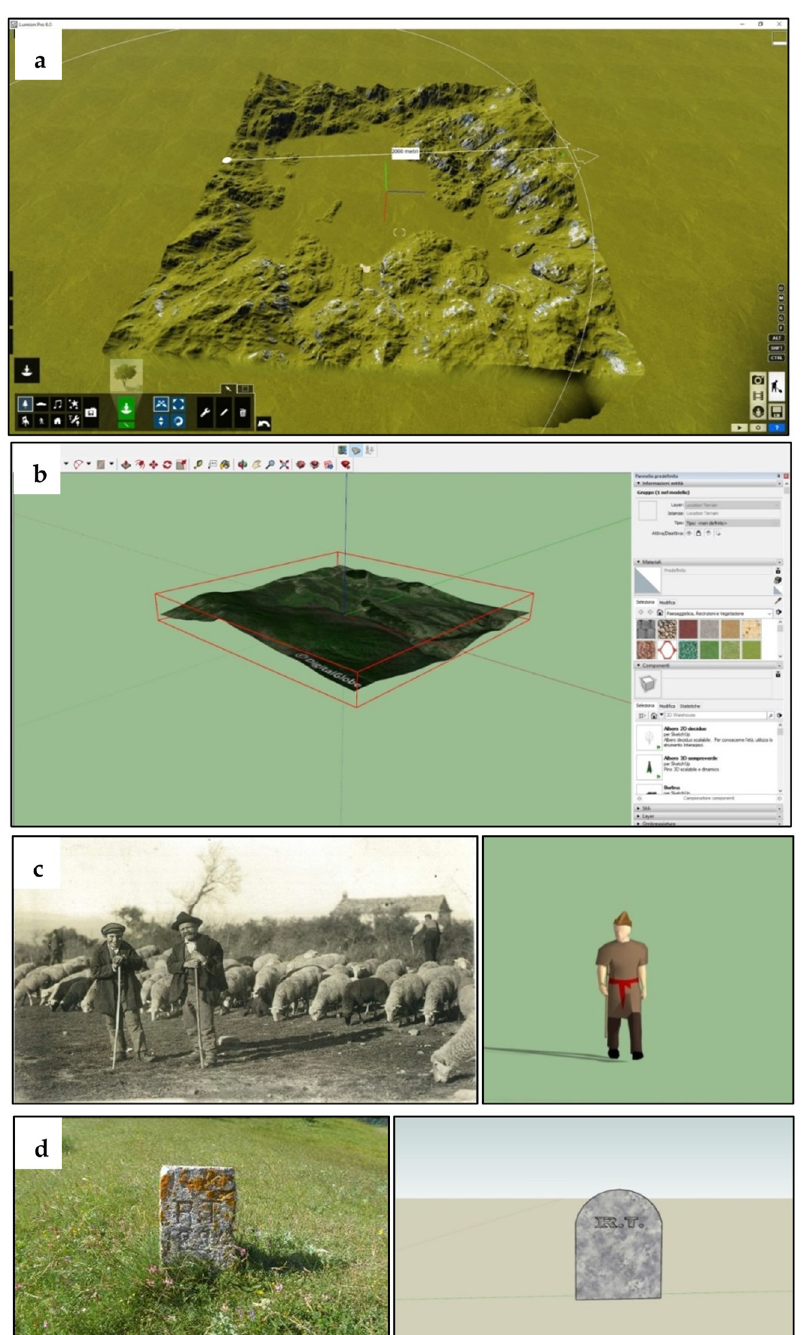
Figure 9. Details of the virtual reconstruction model: ( a ) the area chosen (maximum extension manageable by the Lumion 6.0 software); ( b ) Modelling the terrain through Sketchup 2018; ( c ) Shepherd model construction from historical photo; Source: photo by Giuseppe and Emilo Pilone, Larino, 1887. [111] (p. 41); ( d ) Reconstruction of the limit stones with the capital initial letters of Regio Tratturo; Source: photo by Daniela Adducchio, 2012 [49] (p. 227).